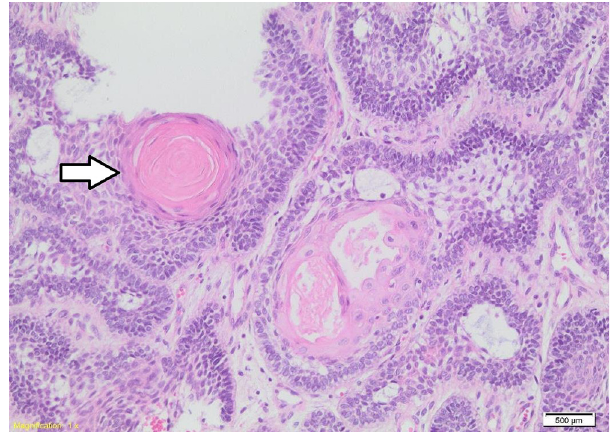
Fig. 10. H&E stained specimenshowing follicular ameloblastoma with acanthomatous